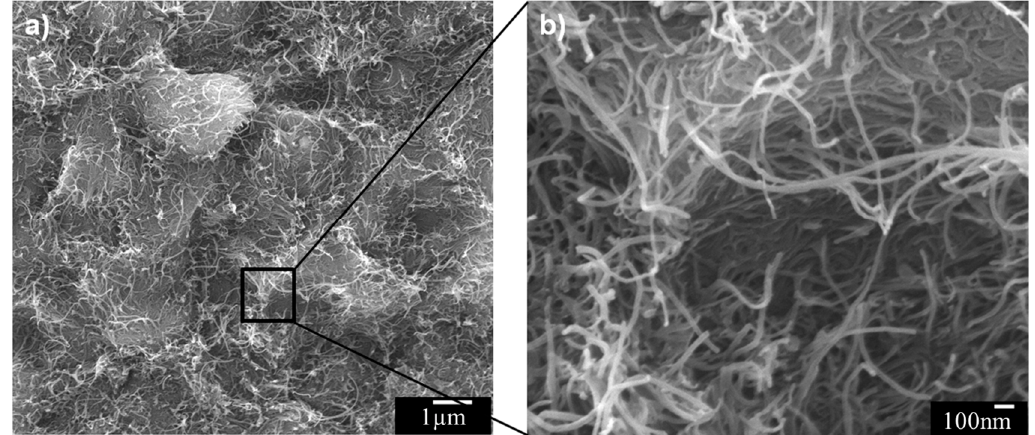
Figure 8. FE-SEM images of the fractured surfaces of CF-reinforced PA6/PP composites (30 wt % PP)